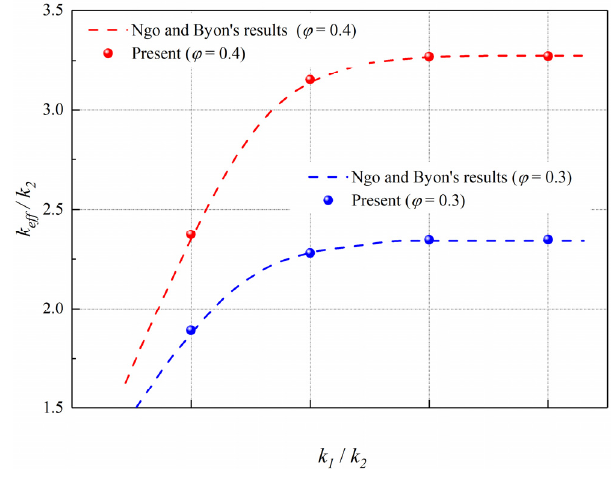
/ k k under different 2 eff ef f / k 2 under different k 1 / k 2 at ϕ = 0.3 and 0.4.